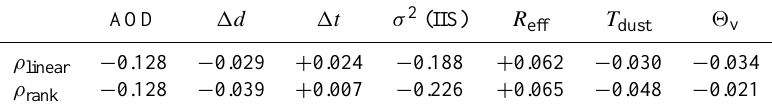
Table 3. Linear and rank correlations between IASI error (with respect to AERONET) and several influencing parameters.